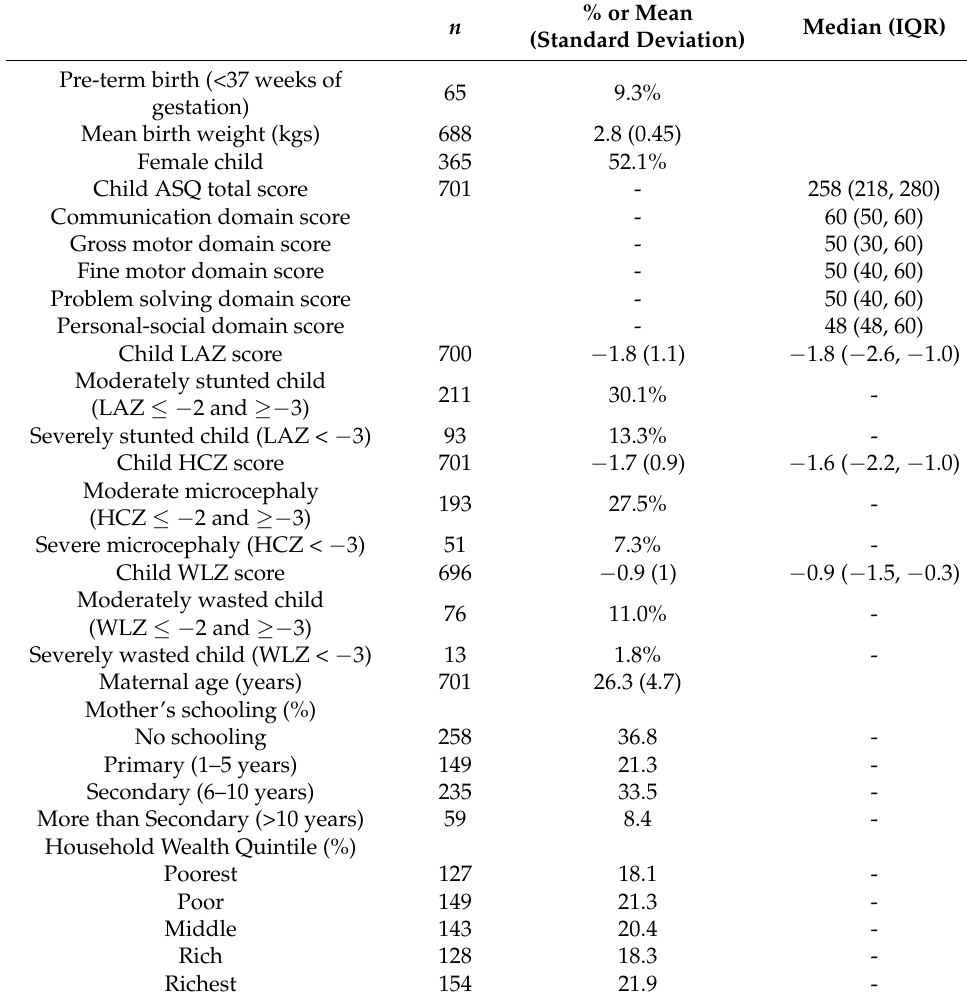
Table 1. Child’s growth and development outcomes at 24 months and other characteristics.